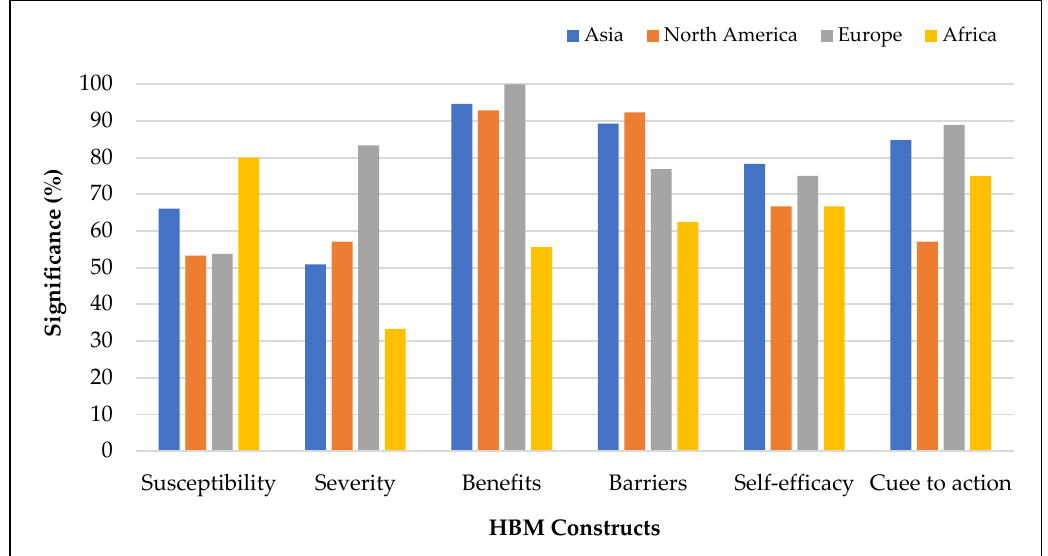
Figure 7. Health belief model constructs associated with vaccination intention by continent with five or more studies.